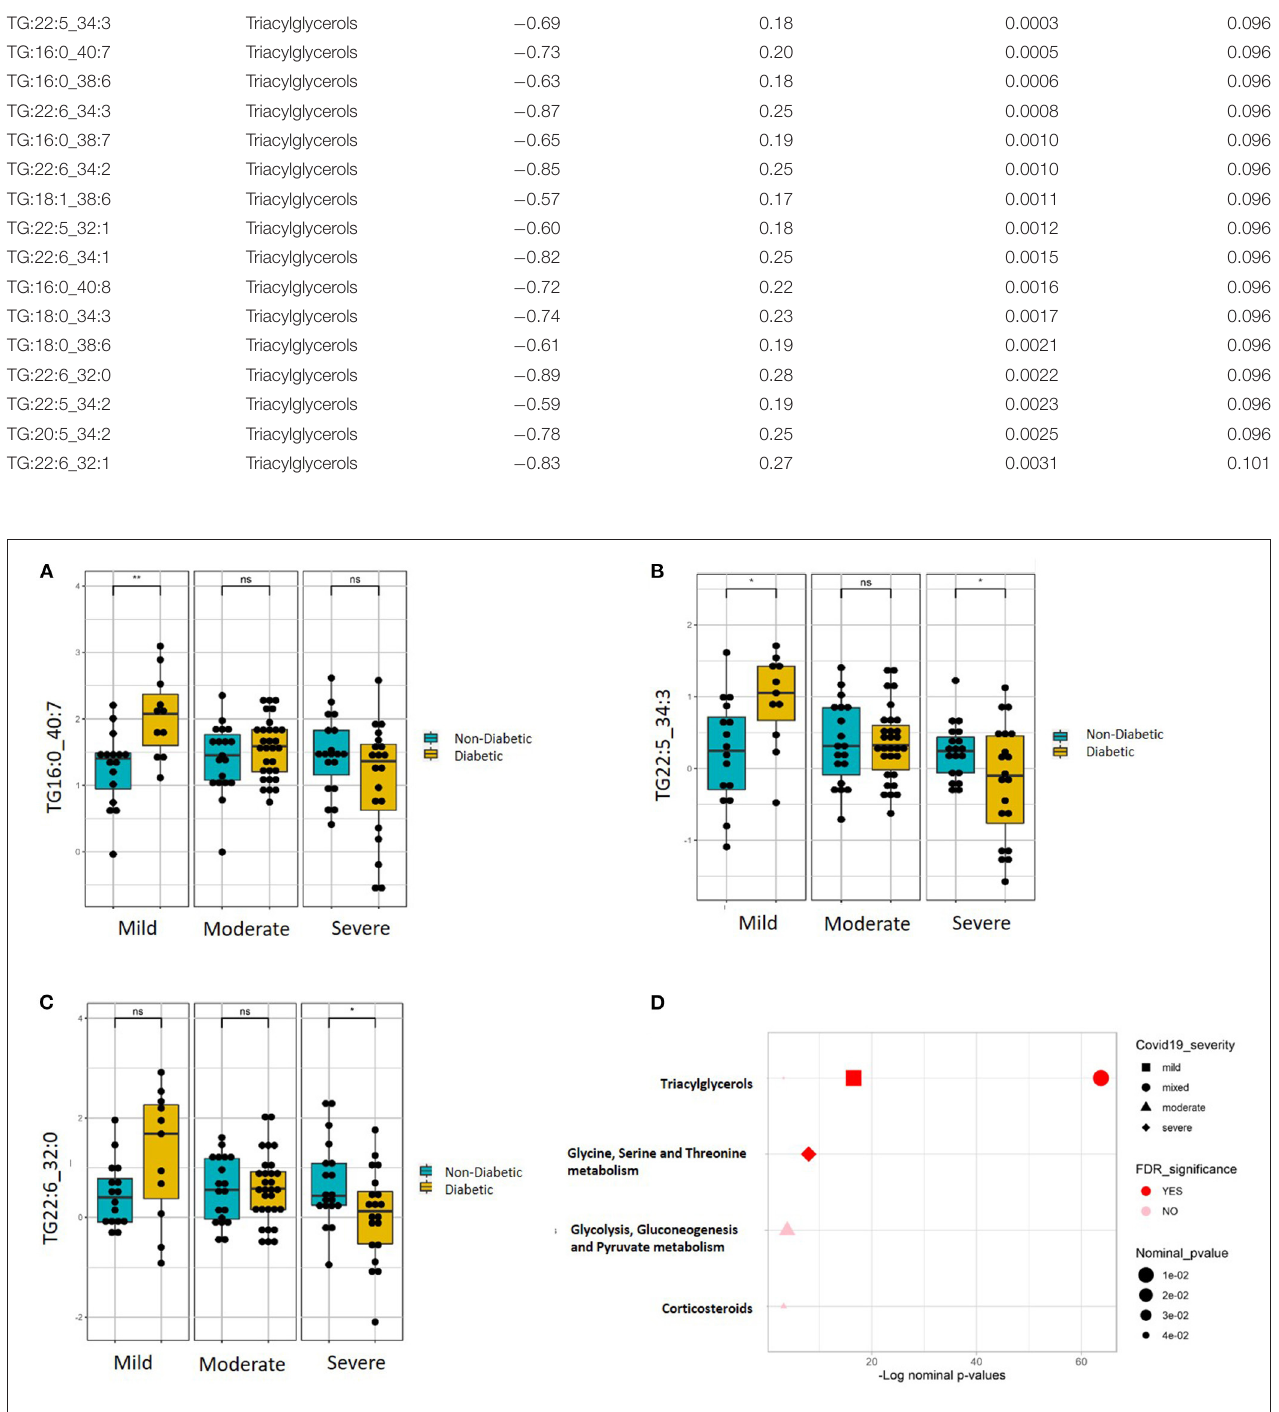
Frontiers in Medicine |